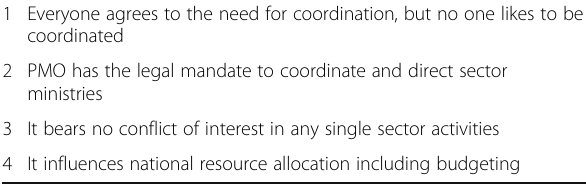
Table 5 The rationale for establishing One Health coordination